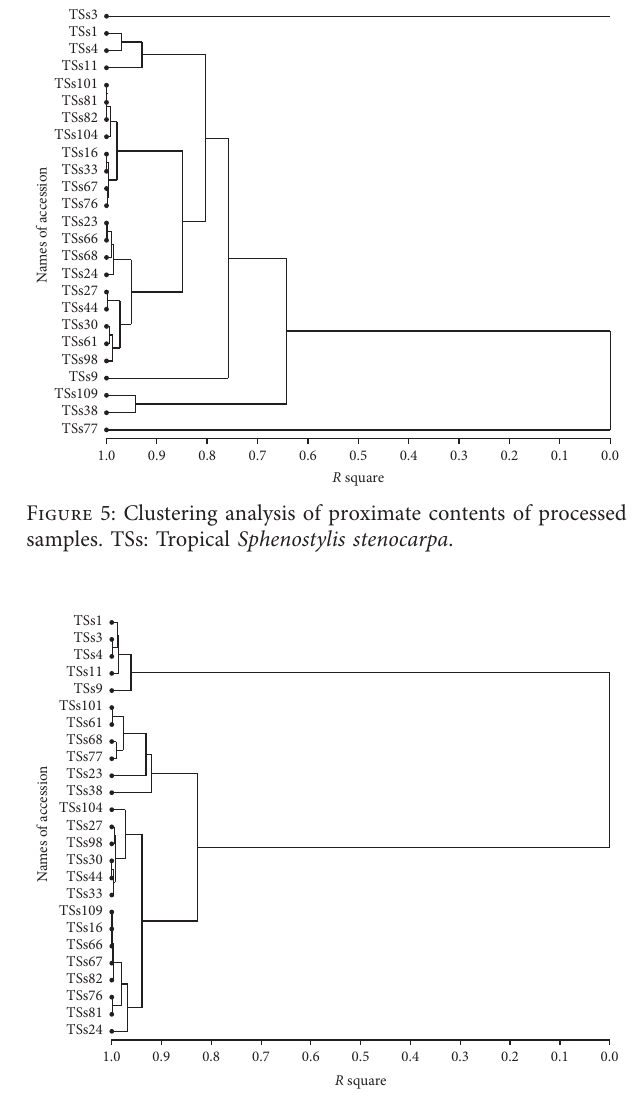
Figure 6: Clustering analysis of proximate contents of unprocessed samples. TSs: Tropical Sphenostylis stenocarpa